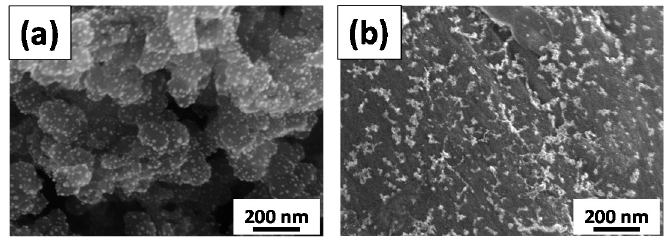
Figure 3. Field-emission scanning electron microscope (FE-SEM) images of different catalyst samples: ( a ) Pd-graphite sphere (GS) and ( b ) Pd-reduced graphene oxide (rGO).